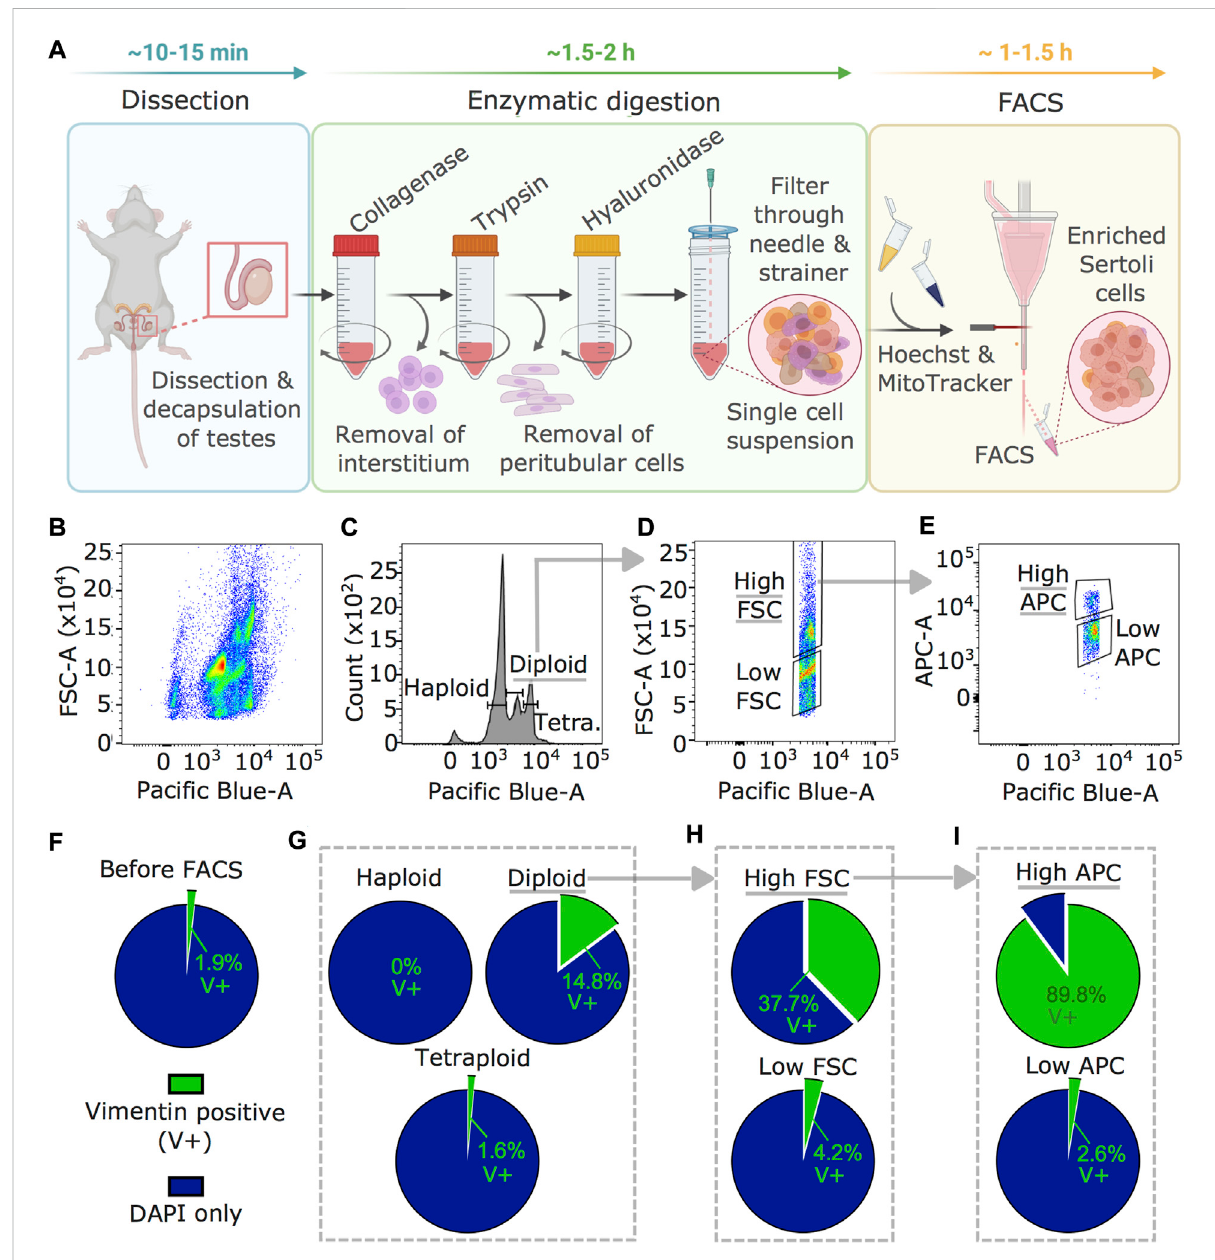
FIGURE 1 Sertoli cells enrichment and visualization by vimentin staining. (A) Work fl ow for Sertoli cells enrichment procedure including testis dissection, enzymatic digestion by collagenase, trypsin, and hyaluronidase, followed by staining with Hoechst and MitoTracker for FACS. Time estimates are indicated for the individual steps (B – E) Results of FACS pro fi les during Sertoli cells enrichment. (B) Hoechst signal (Paci fi c Blue) plotted against FSC (indicatingsize)showingseveralcellpopulationsinthesinglecelltestispreparation. (C) DiploidcellsselectedusingtheHoechstsignal, (D) large cells using a high FSC signal, then (E) cells with high mitochondrial activity using MitoTracker (high APC) signal. (F – I) Enrichment of Sertoli cells (vimentin-positive, V+) in different FACS fractions. Percentage of V+ cells of all cells (DAPI) is shown (F) before FACS, (G) after selection of diploid cells, (H) aftersizeselectionbyhighFSCwithindiploidcells,and (I) after gatingonhighmitochondrialactivitywithindiploid,highFSCcells(weighted averages of four independent replicates). Counts are summarized in Supplementary Table S2. Underlined fractions in (B – I) correspond to gates chosen for Sertoli cells enrichment. Arrows indicate implementation of gate settings before further partitioning into